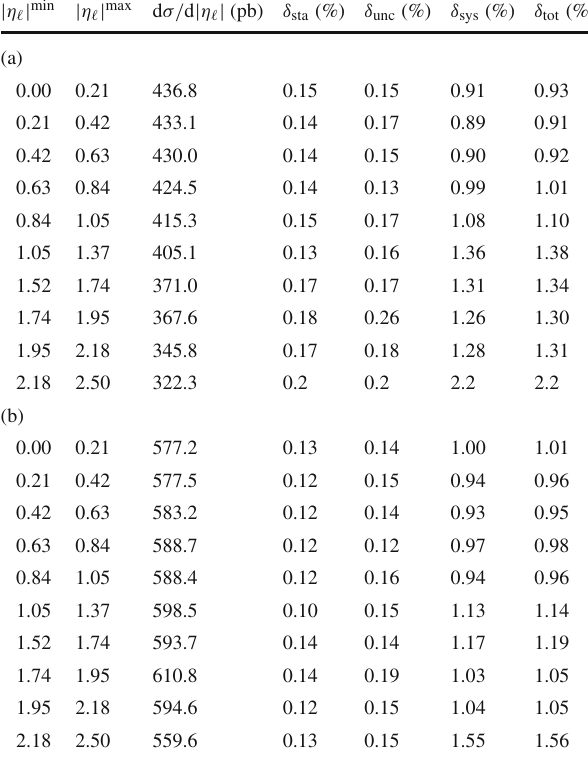
Table 23 Differential cross section for the W − → e − ¯ ν (a) and W + → e + ν (b) processes, extrapolated to the common fiducial region. The relative statistical ( δ sta ), uncorrelated systematic ( δ unc ), correlated systematic ( δ sys ), and total ( δ tot ) uncertainties are given in percent. The overall 1 . 8% luminosity uncertainty is not included